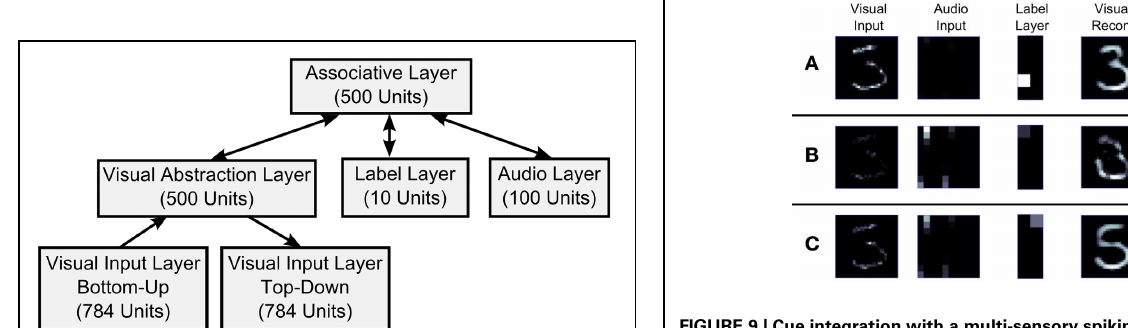
FIGURE 9 | Cue integration with a multi-sensory spiking DBN. (A) When presenting only an ambiguous visual input to the DVS, the network in the absence of auditory input will alternate between recognizing a “3” or a “5” (see also Figure 7 ). (B) When presenting only an ambiguous auditory input to the cochlea, the network in the absence of visual input will alternate between recognizing a “0” or a “5.” (C) By combining the two inputs (mixing at 50%), the network reliably classifies the two ambiguous patterns as class “5,” which is the only consistent